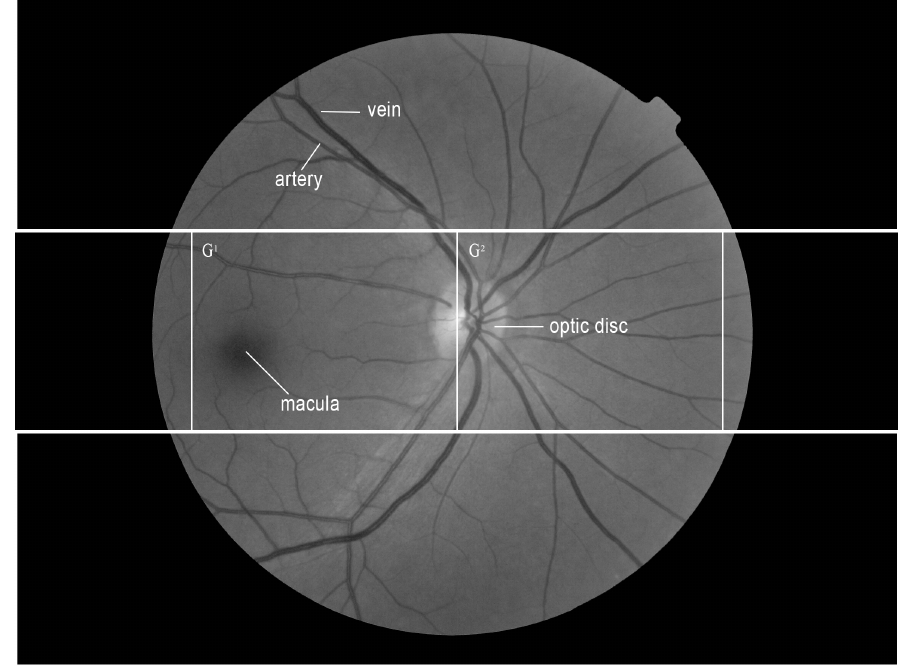
Figure 3. The divisions resulting from preprocessing in the detection of the